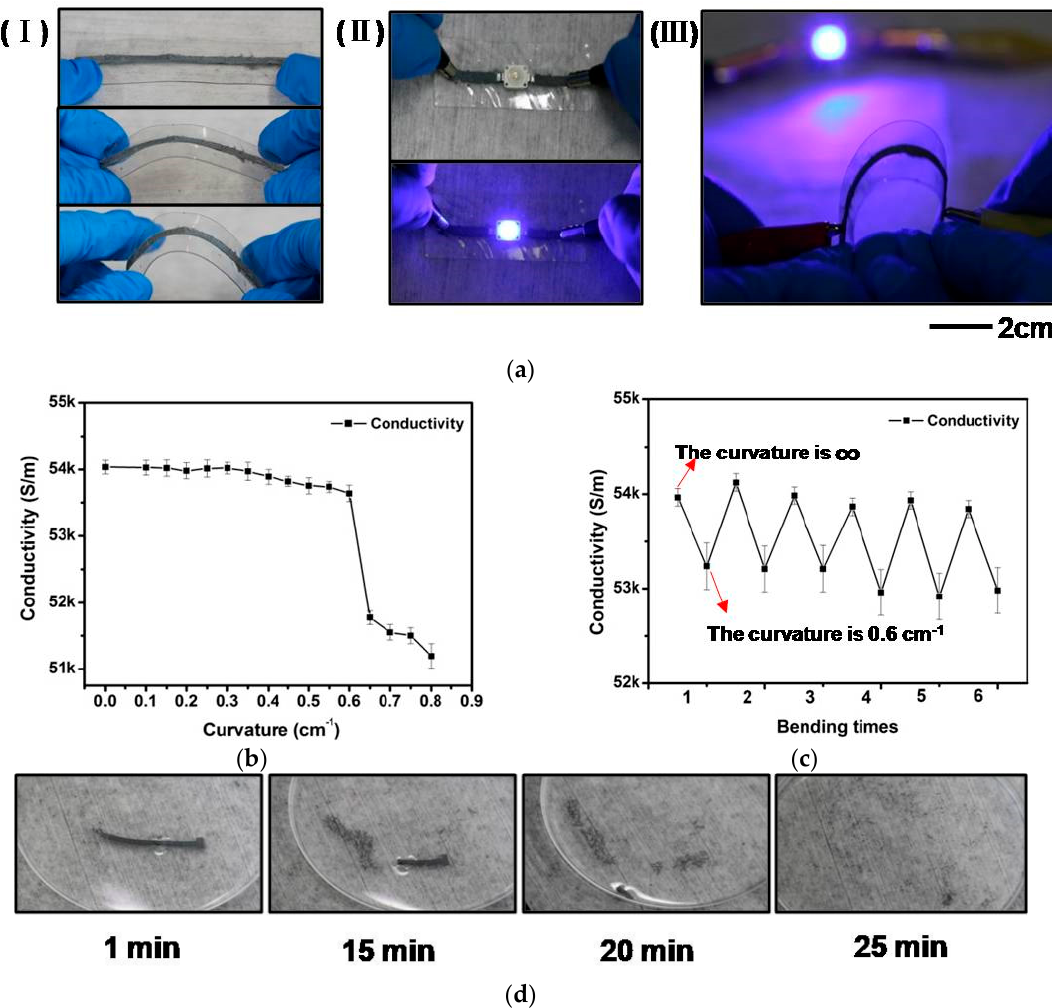
Figure 4. ( a ) ( I ) A printed pattern were bent into different curvatures; ( II ) The printed pattern as interconnects to connect a LED with a power supply; ( III ) An LED was lit by a printed interconnect in an extremely curved state; ( b ) The conductivity of a bioresorbable pattern in different curvatures; ( c ) Changes in conductivity when a bioresorbable pattern was bent repeatedly from 0 to 0.6 cm − 1 in curvature; ( d ) A dissolution process of a printed pattern.